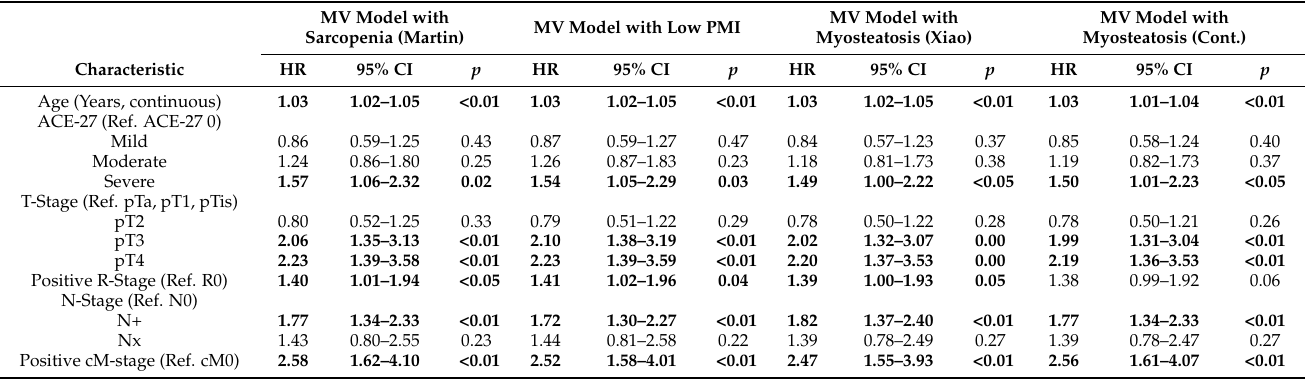
Table 4. Multivariate Cox-regression analyses for different body composition measurements for OS in the 657 patients who underwent radical